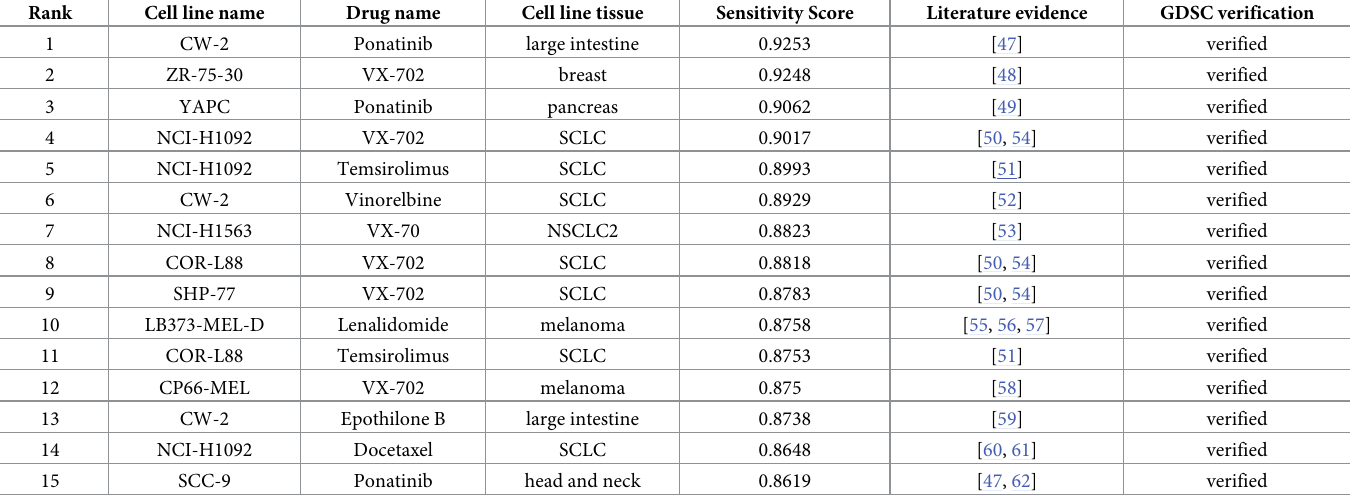
Table 10. Top 15 novel sensitive pairs and pieces of evidence for these